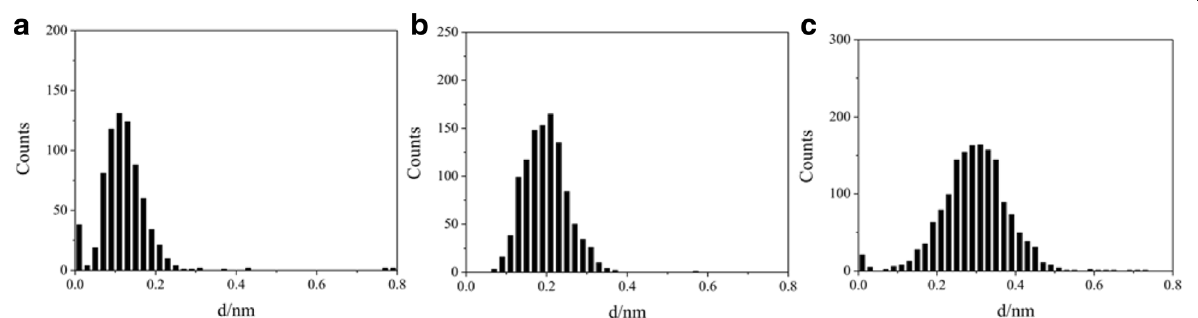
Fig. 4 Breaking off distances for iodine-terminated alkanes. Breaking off distances of a 1,4-butanediiodo, b 1,5-pentanediiodo, and c 1,6-hexane- diiodo obtained from conductance curves between 10 − 5.0 G 0 and 10 − 0.3 G